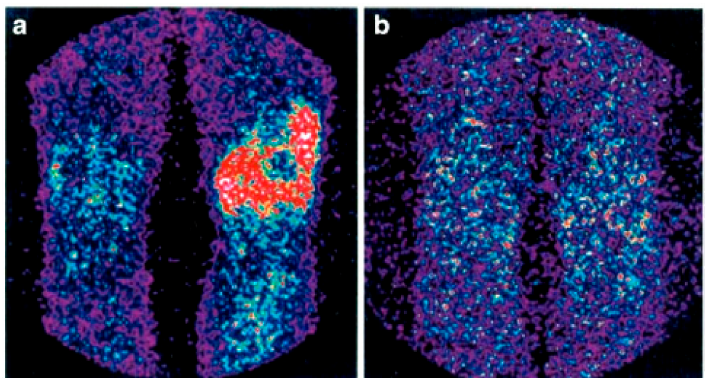
Figure 3. Scintigraphy with 99m Tc-infliximab before ( a ) and 4 months after ( b ) intra-articular administration of infliximab. Red colour represents uptake of the 99m Tc-infliximab in scintigraphy (from Conti, F.; et al. Arthritis Rheum, 2005 , 52 , 1224–1226 [68]).